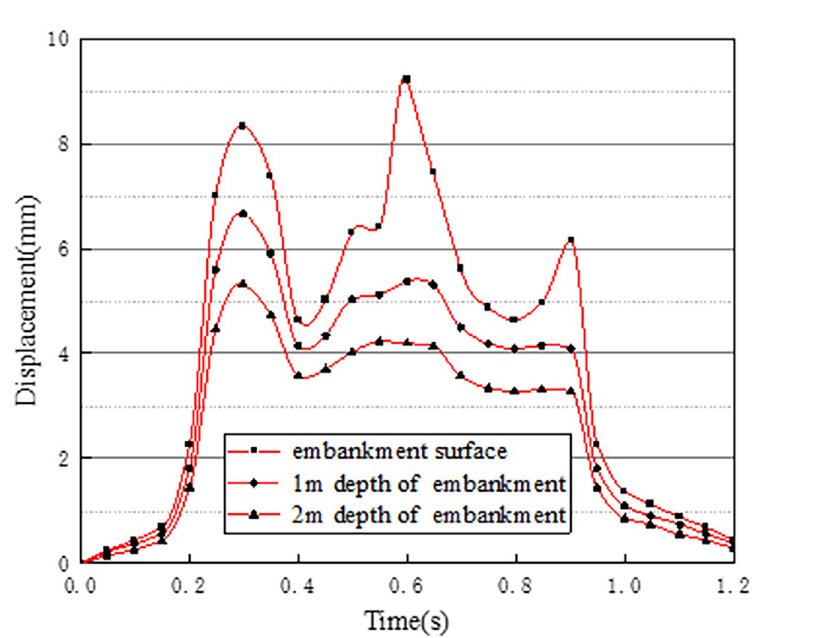
Fig 16. Displacement time history curves at different depths.